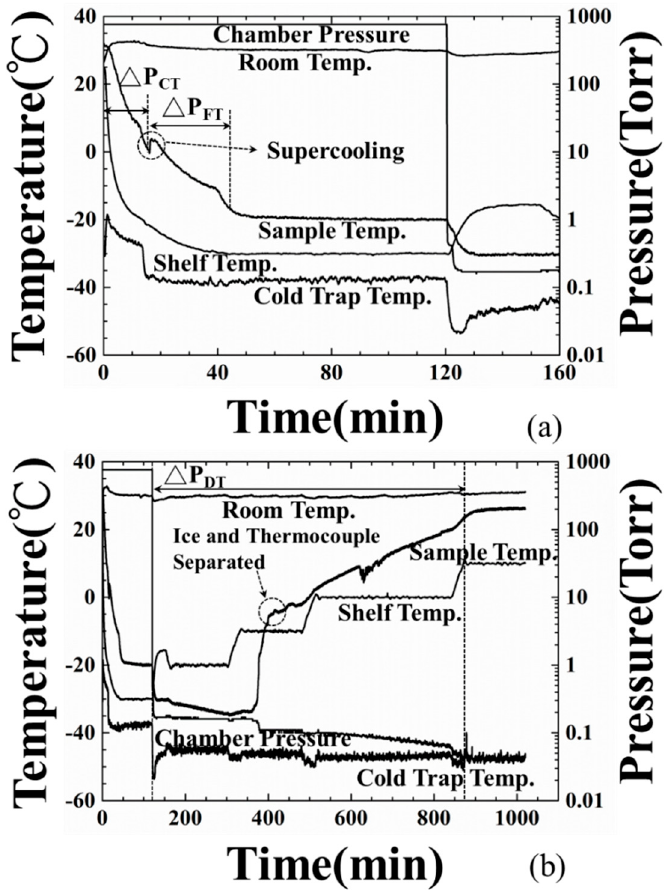
Figure 5. Temperature (room, shelf, sample, cold trap) and pressure (chamber) variations during freeze-drying process at ( a ) the freezing stage and ( b ) drying stage. freeze-drying process at ( a ) the freezing stage and ( b ) drying